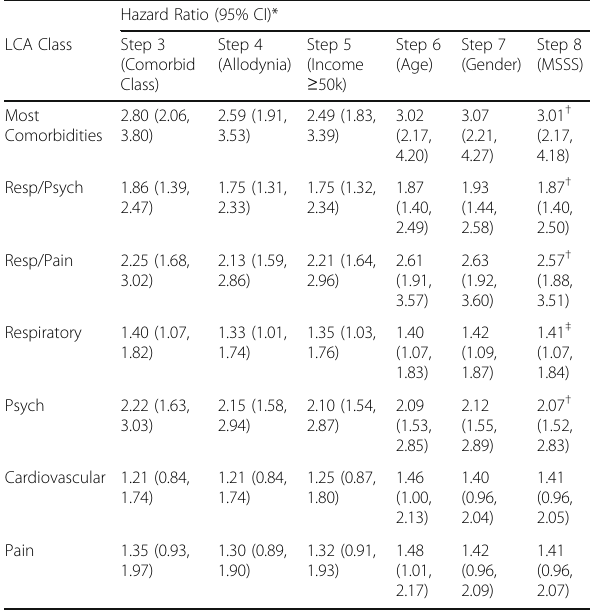
Table 1 (abstract O36). Forward stepwise model* for the discrete time hazard to chronic migraine onset in comorbid classes of migraine in individuals with episodic migraine at